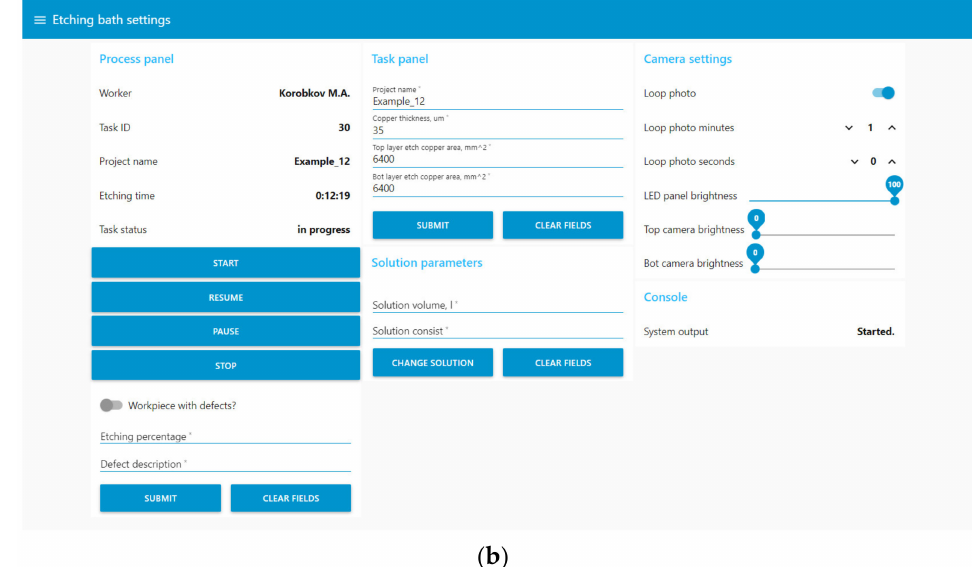
Figure 13. The user interface of the digital production site in Node-Red UI. ( a ) Window for displaying data from the digital site; ( b ) window with settings of the digital site.